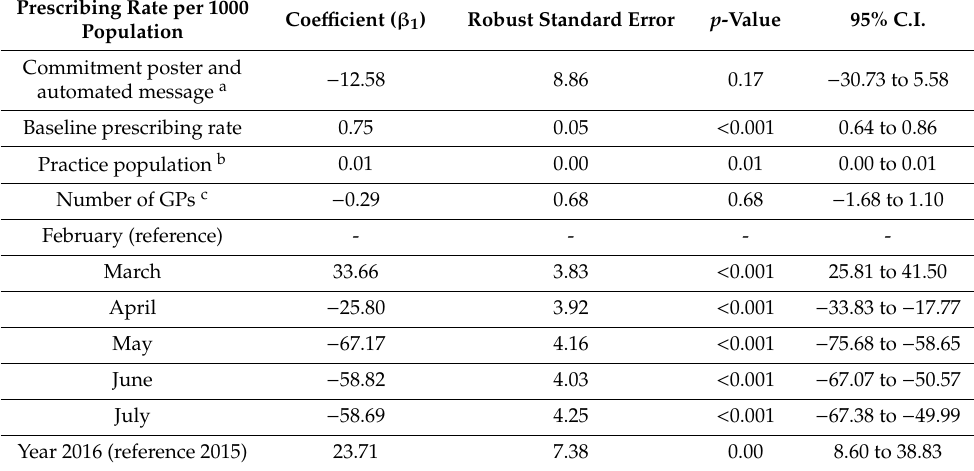
Table 2. Regression estimates for the e ff ect of the commitment poster and automated message on the number of antibiotic items